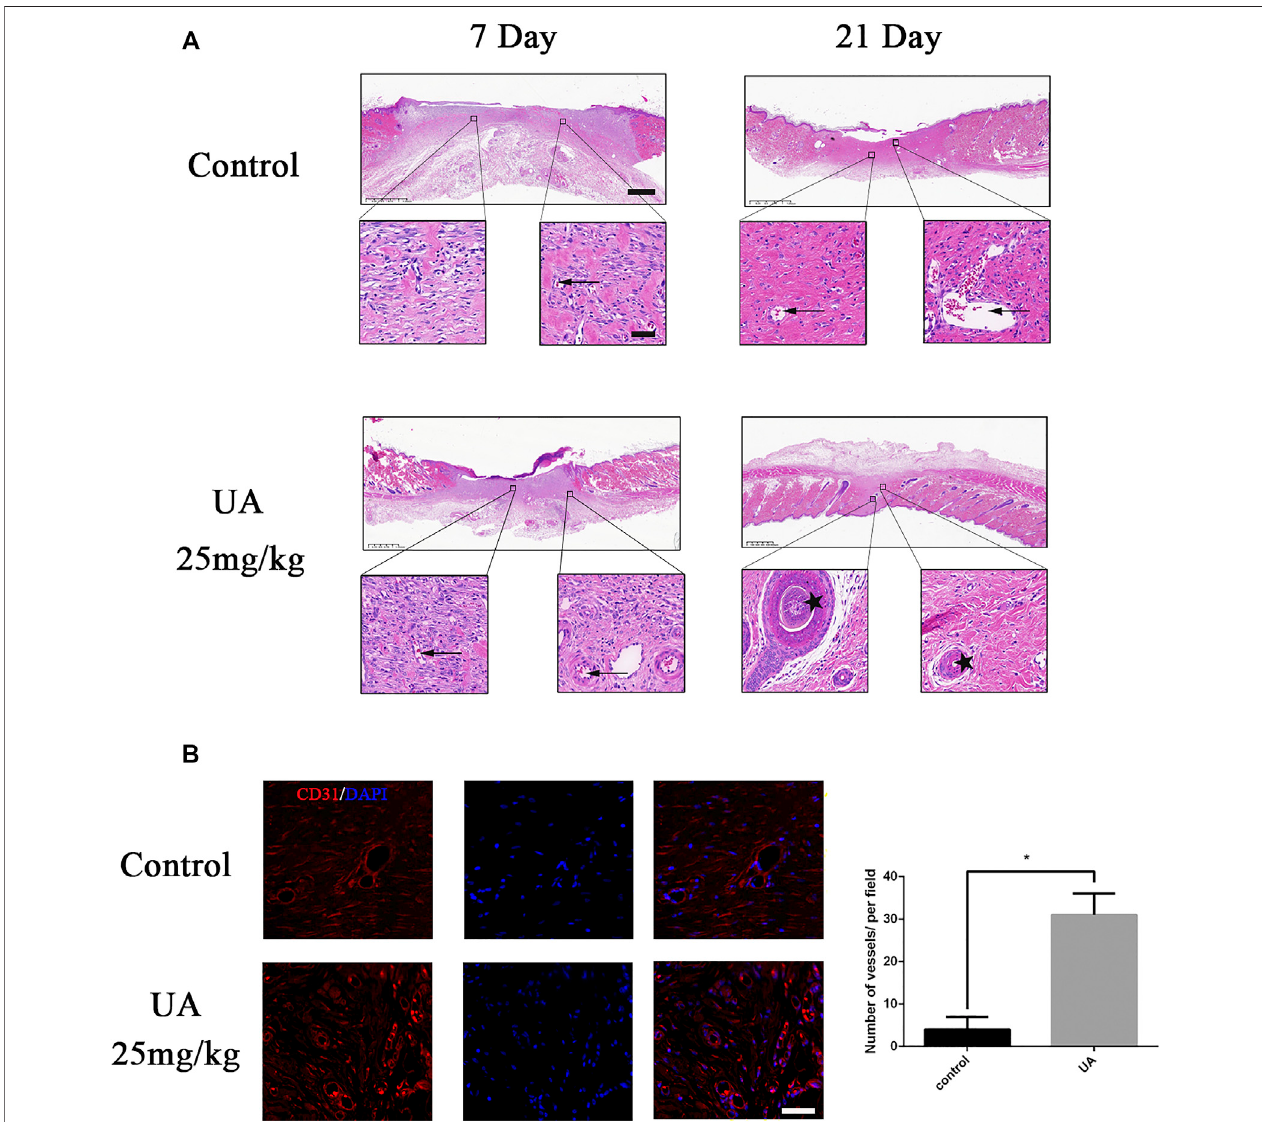
FIGURE 6 | UA promotes angiogenesis in vivo . (A) HE staining of the wound surface at 7 and 21 days after operation (scale bar = 100 μ m, 50 μ m). Arrows represent blood vessels, and the fi ve-pointed star represents keratinization. (B) Immuno fl uorescence staining images of CD31 (scale bar = 50 μ m). Statistics of the immuno fl uorescence experiment. The data represent mean ± SD ( n = 3) (* p < 0.05).